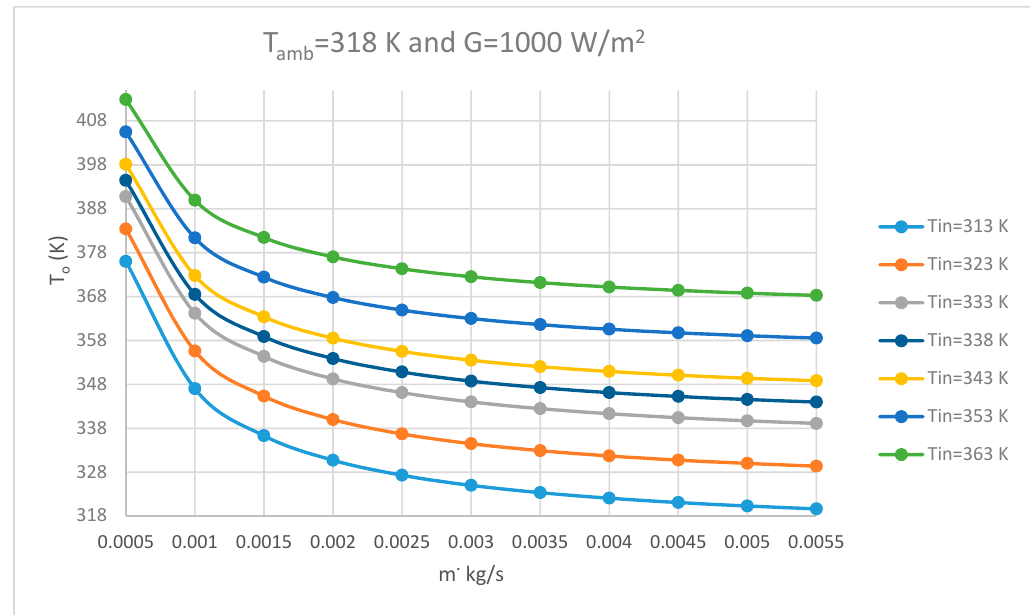
Figure 15. Outlet water temperature for different inlet temperature versus flowrate. Fluids 2018 , 3 , x FOR PEER REVIEW